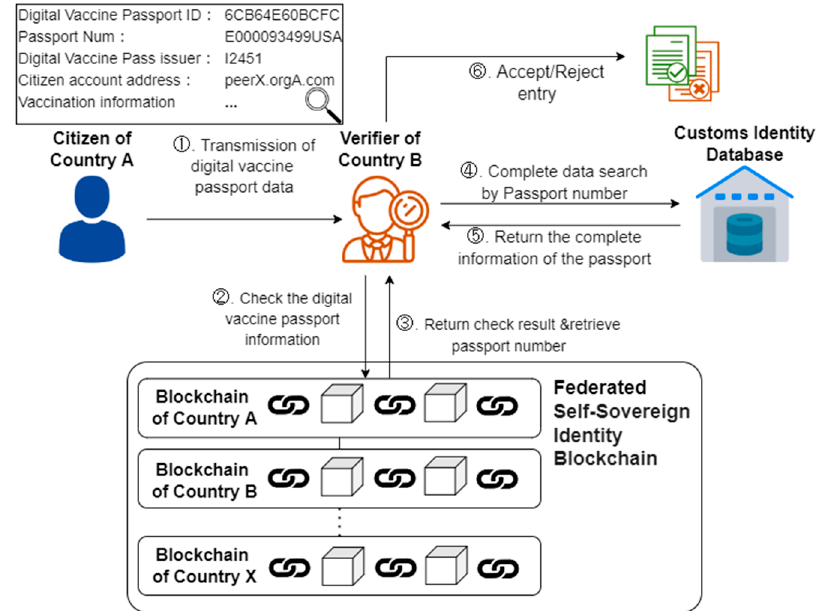
Figure 8. Digital COVID-19 vaccine passport verification scenario.